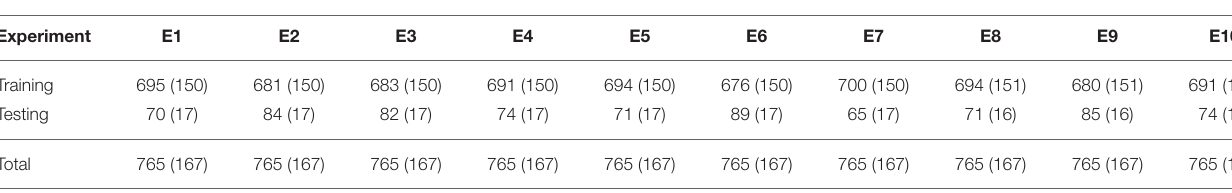
TABLE 3 | The distribution of the 10-fold cross-validation